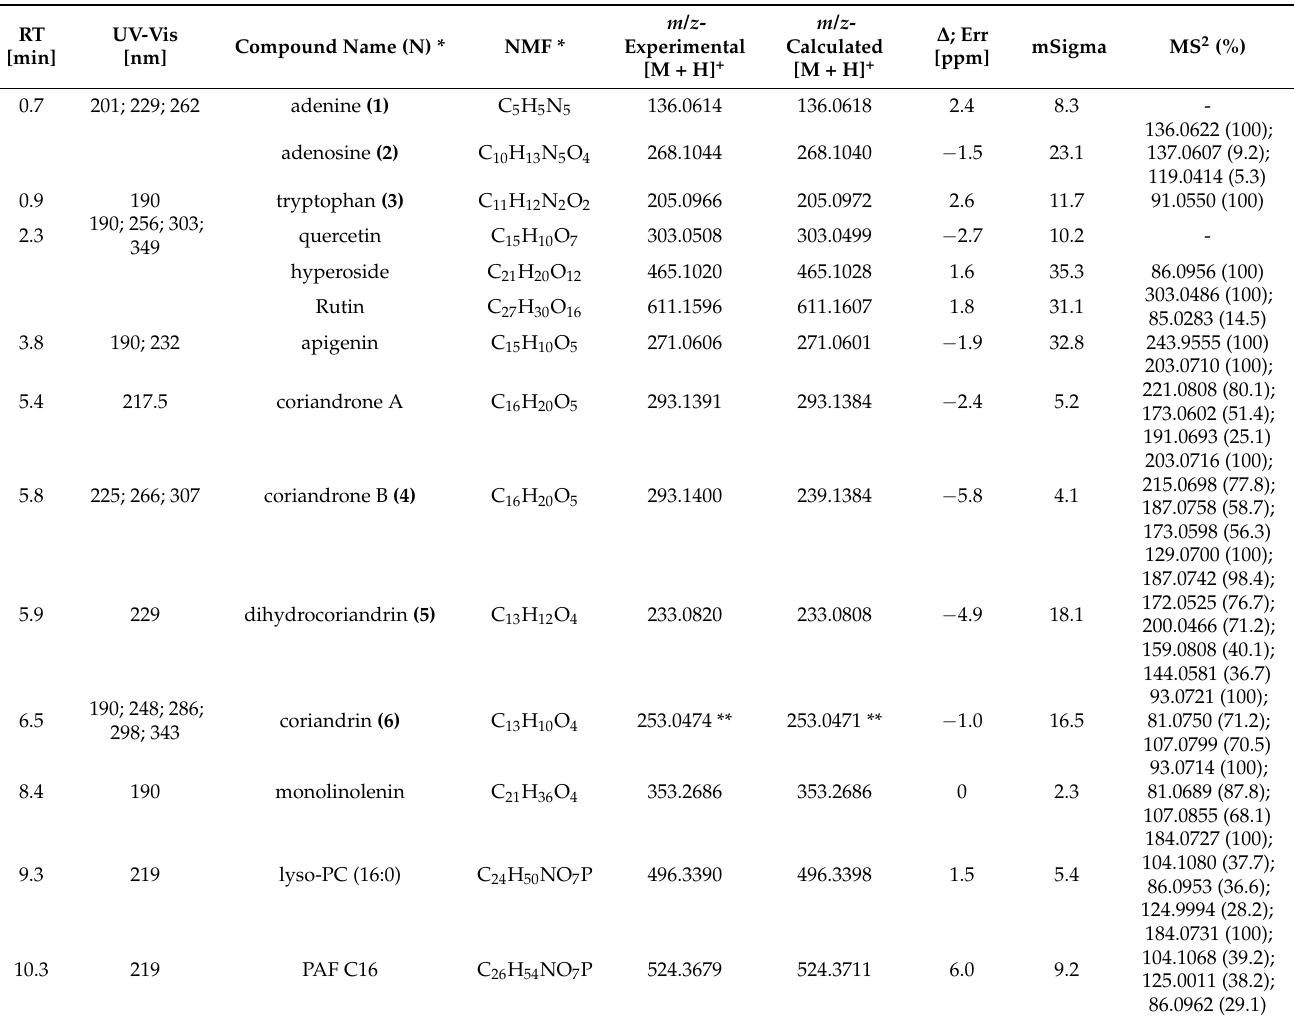
Table 2. Compounds identified at CSEE thought UPLC/DAD-ESI/HRMS/MS